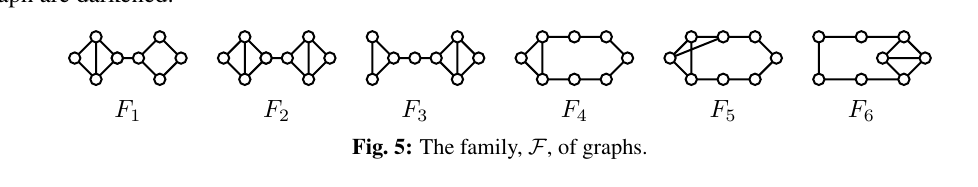
Fig. 5: The family, F , of graphs.